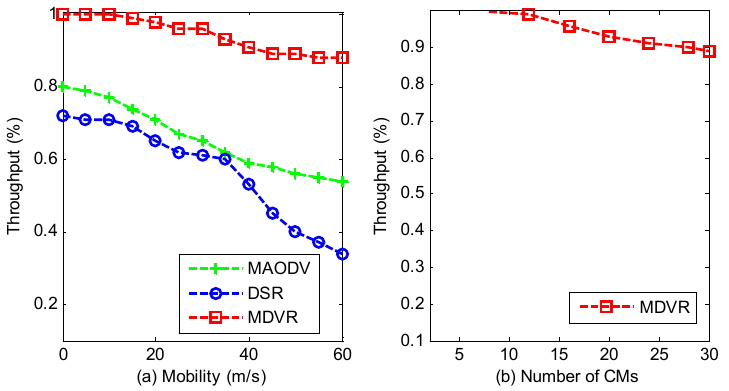
Figure 5. ( a ) UGAVs-MDVR throughput versus mobility; ( b ) UGAVs-MDVR throughput versus the number of CMs .